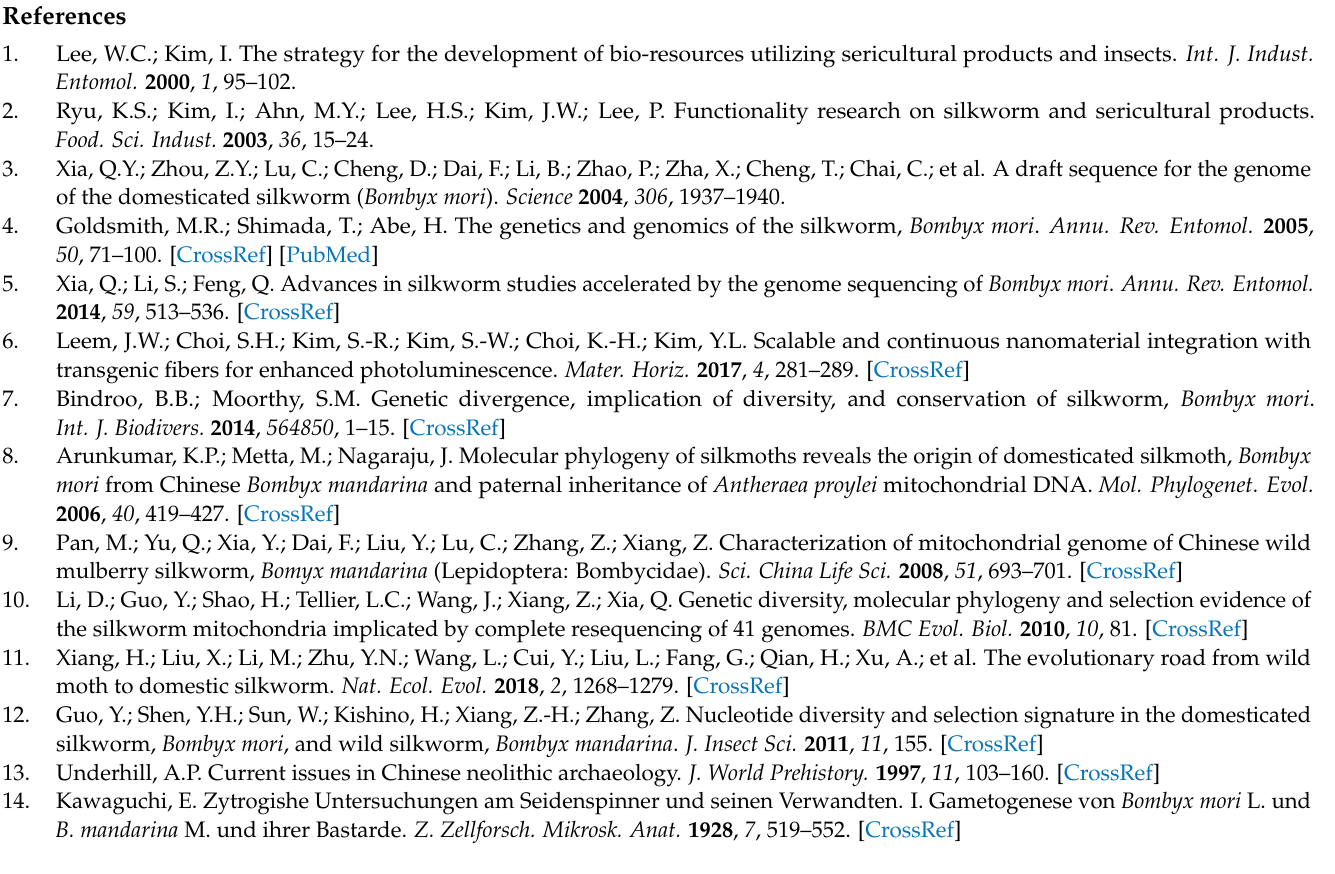
Table S2: Summary of mitochondrial genomes of 37 B. mori strains and four B. mandarina individuals obtained in this study, Table S3. Mitochondrial genome characteristics, Table S4: The A + T-rich region sequences of B. mandarina reported in Sun et al. [22], Dataset 1. Input files of Arlequin for population analysis, Dataset 2. Xml file of BEAST2 for Skyline plot analysis. References [10,22,23,35–48] are cited in the supplementary